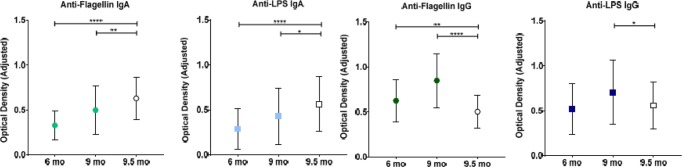
Anti-Flagellin and anti-LPS immunoglobulin concentrations in Pakistani infants.Closed shapes indicate means±SDs in Pakistani infants over the follow-up period. Open shapes indicate means±SDs values in 36 healthy Boston infants with a mean age of 9.5 months. n = 380 for all immunoglobulins in Pakistani infants at 6 and 9 months of age; n = 36 for all immunoglobulins in Boston infants at 9.5 months of age. **** p< 0.0001, ** p< 0.01 and * p< 0.05 for comparisons of mean biomarker concentrations in Pakistani infants with those of healthy Boston infants (unpaired t tests).